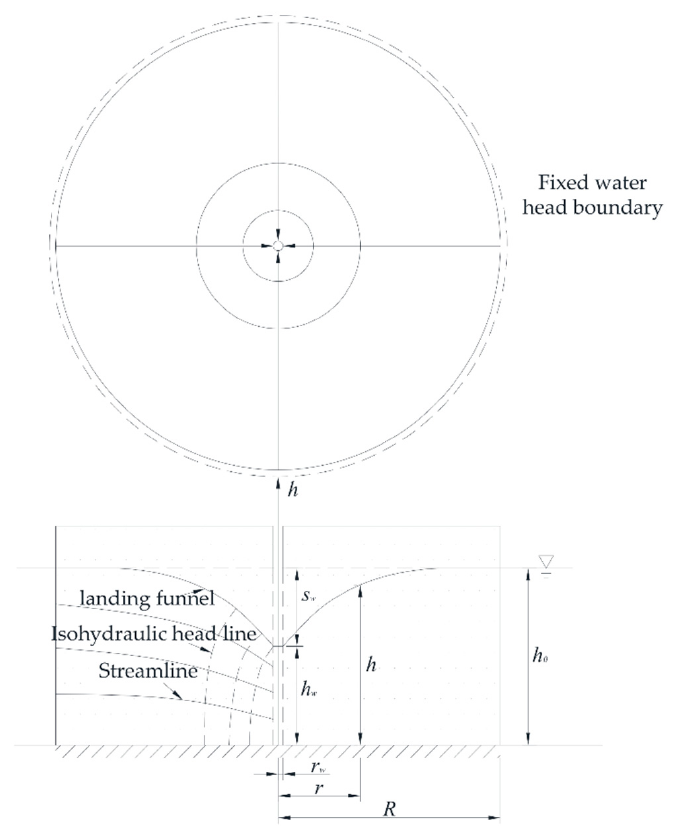
Figure 12. Schematic of Dupuit stabilized submerged well flow.